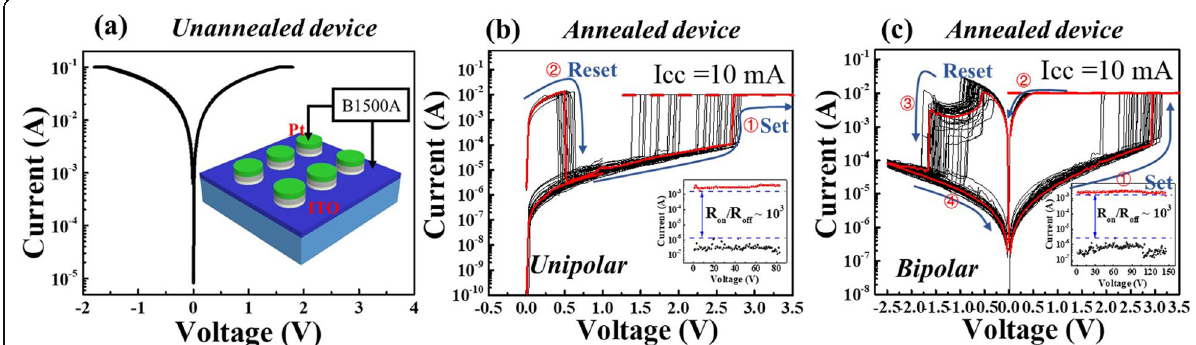
Fig. 3 a The I-V curve for the unannealed Pt/Al/ITO device. The inset shows a schematic diagram of the electrical measurement. The Pt top electrode is the applied bias voltage, and the ITO is grounded. b The 50 – cycle I-V curve for unipolar switching (annealed for 4 h). The dashed line denotes the compliance current Icc = 10 mA. The red line indicates the first set process and reset process. The arrows indicate the voltage sweeping direction. The read voltage is set to 0.1 V. The inset shows the endurance characteristic. c The 50-cycle I-V curve for bipolar switching (annealed for 4 h). The inset shows the endurance characteristics. The read voltage is set to 0.1